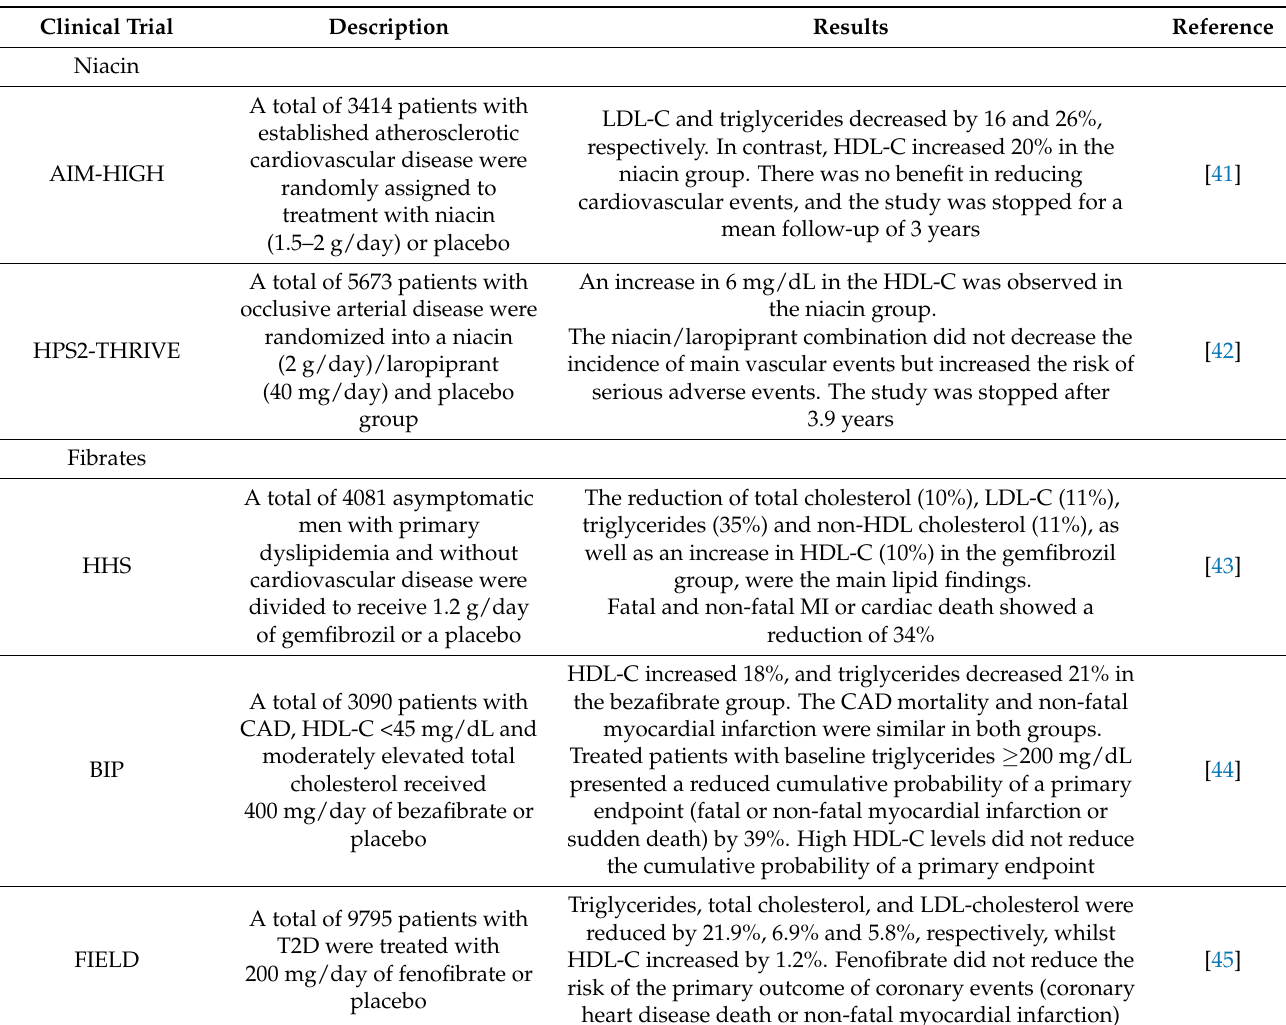
Table 1. Examples of the main studies focusing on pharmacological HDL-C increase as a target to prevent coronary